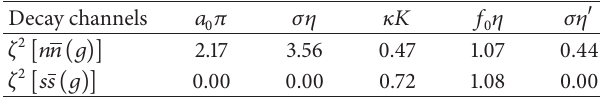
Table 5: The coefficients 𝜁 2 of 𝜉 and 𝜉 󸀠 in the ideal mixing. Decay